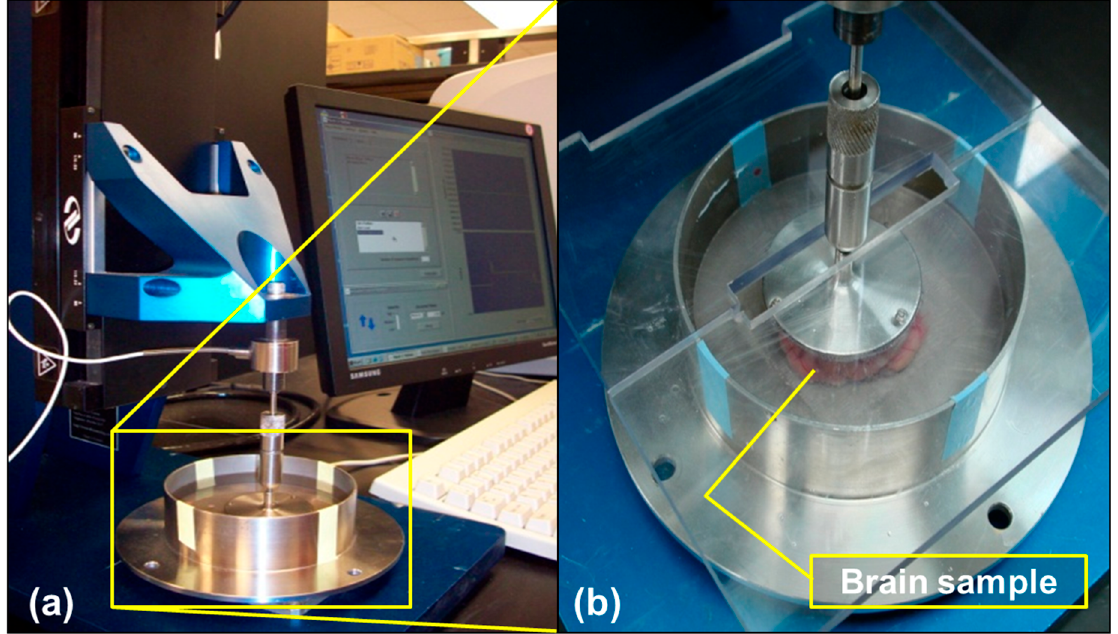
Figure 1. ( a ) Quasi-static compression test on the porcine brain using the Mach-1 ™ Micromechanical Testing System (BIOMOMENTUM, Quebec). ( b ) Wet porcine samples were immersed in 0.1 M neutral buffered PBS during quasi-static compression at strain rates of 0.00625, 0.025, and 0.1 s − 1 .